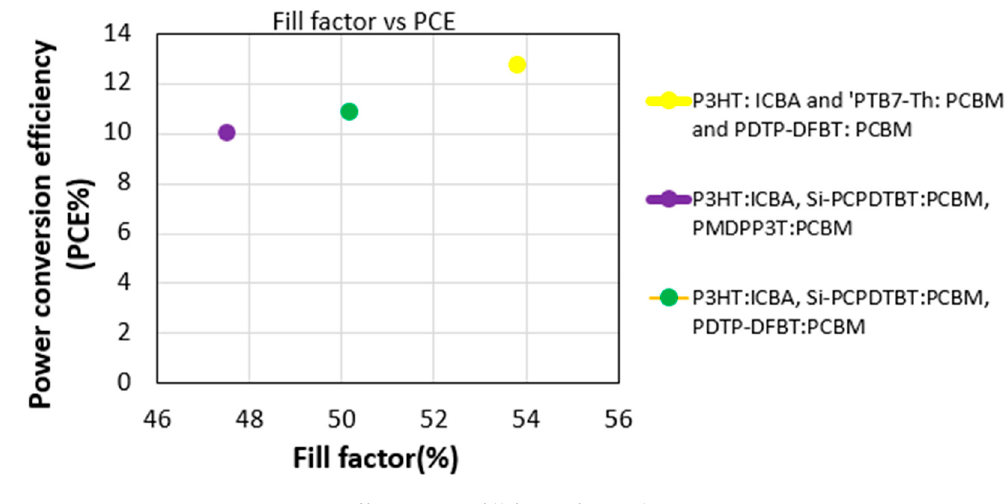
Figure 11. Efficiency vs. fill factor for multi-junction PSC.